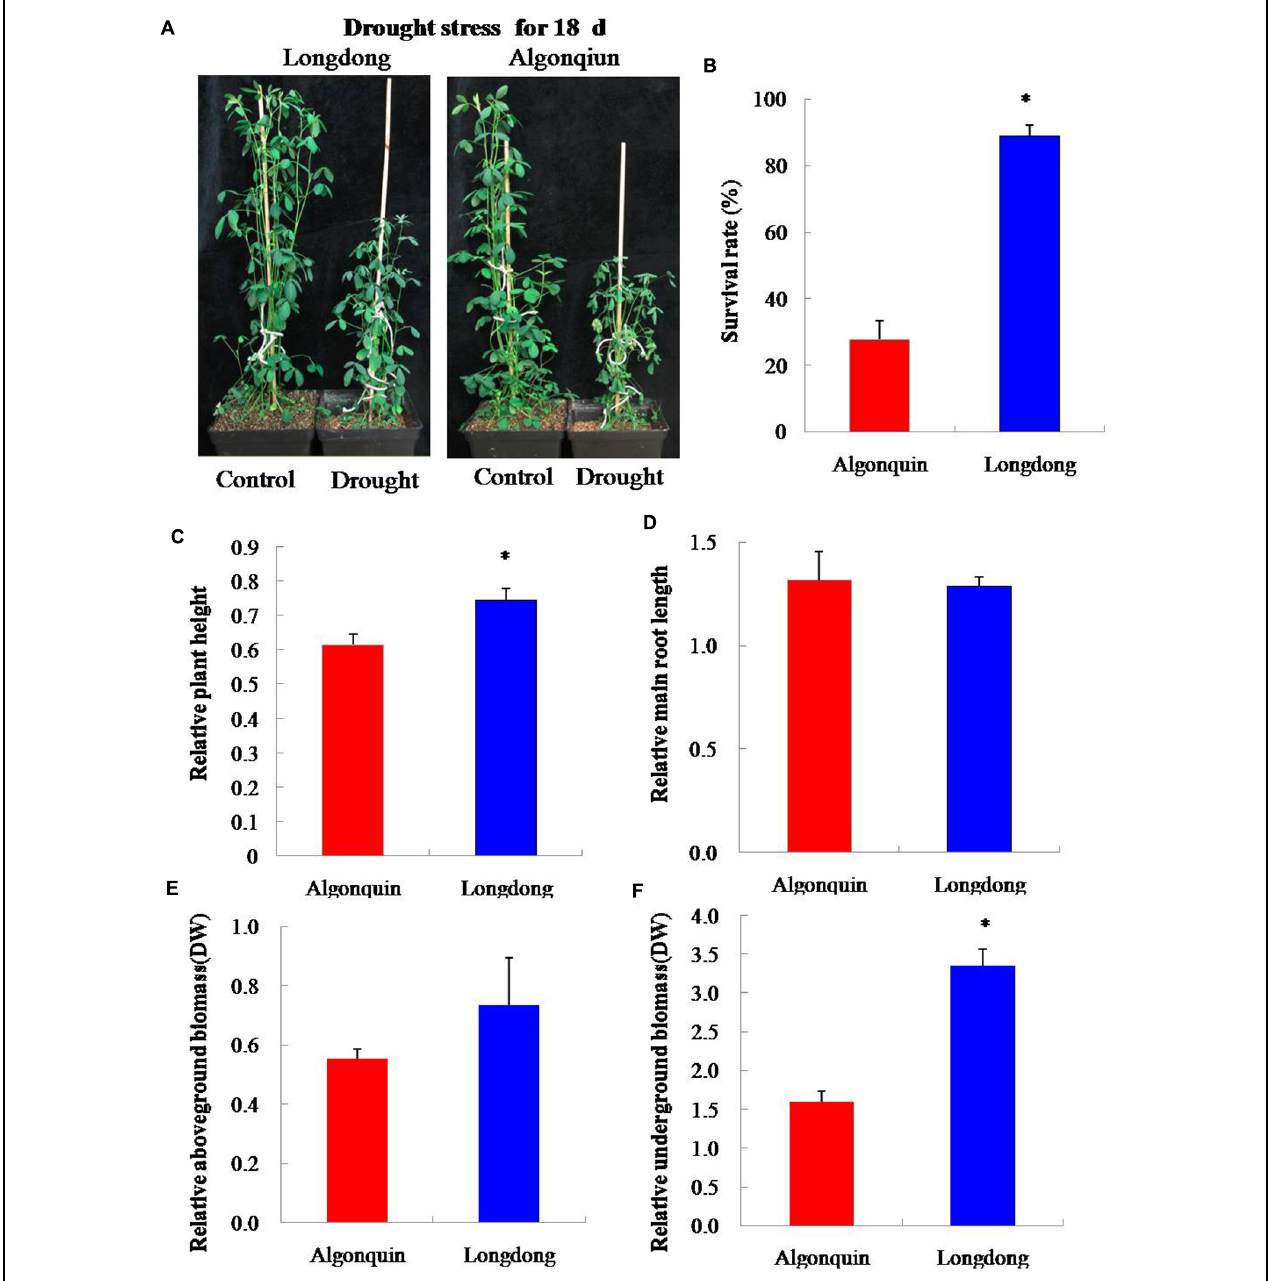
FIGURE 5 | Plants response to drought stress. (A) Four-week-old plants of Algonquin and Longdong treated with drought stress for 18 days. Plants were photographed after 18 days stress treatment. (B) Survival rates of two varieties after re-watering 7 days were calculated from the results of three independent experiments ( n = 20). (C,D) Relative plant height and relative main root length were compared after drought treatment 18 days relative to control ( n = 8). (E,F) After drought treatment 18 days, the relative aboveground and underground biomass (DW, dry weight) per plant were analyzed under drought stress relative to control ( n = 8). The results shown are means ± SE. Asterisk symbols indicate significant differences from Algonquin at P < 0.05 (Student’s t